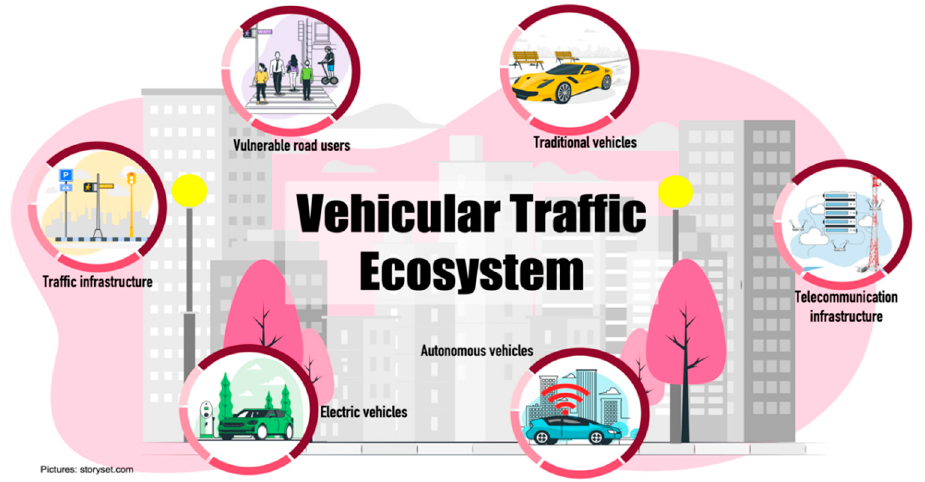
Figure 1. A new vision for the Vehicular Traffic